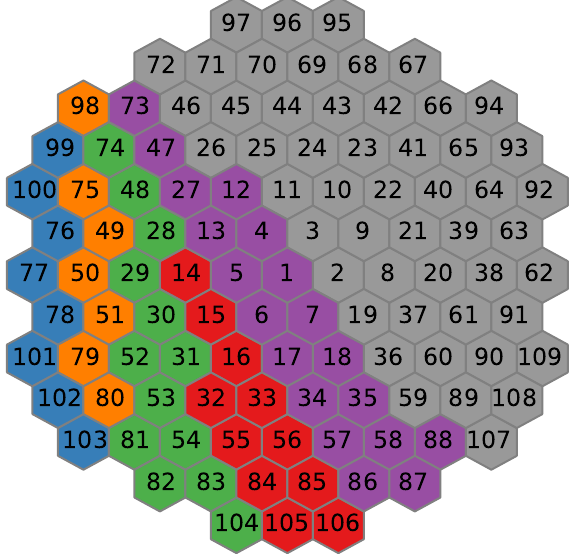
Figure 12. The SPHERE-2 PMT mosaic scheme. PMT numbers are indicated. PMTs are colored according to their current curve type in the 2012-3 flight with colors as in Figure 11. This observation itself confirms the consistency of the detector orientation and posi- tion monitoring.